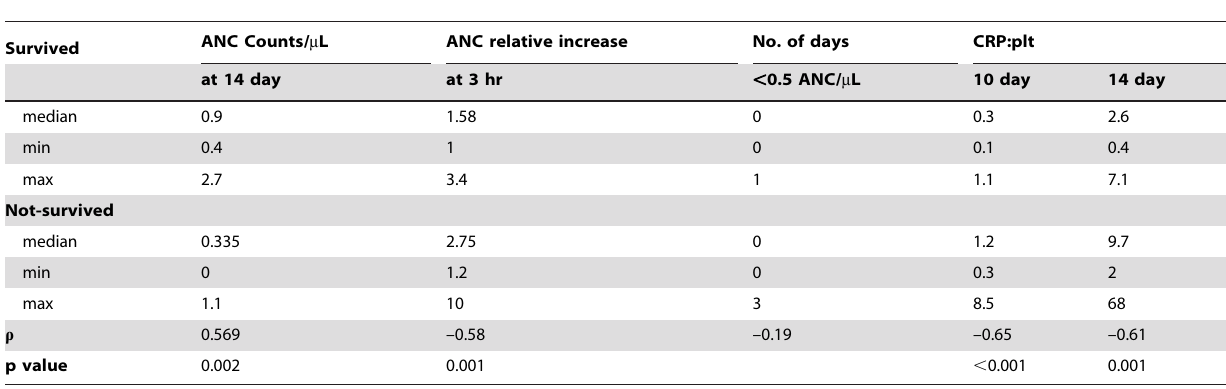
Table 4. Spearman rank correlation ( r ) of ANC counts- and CRP-based parameters with survival in irradiated G. minipig (n =30).